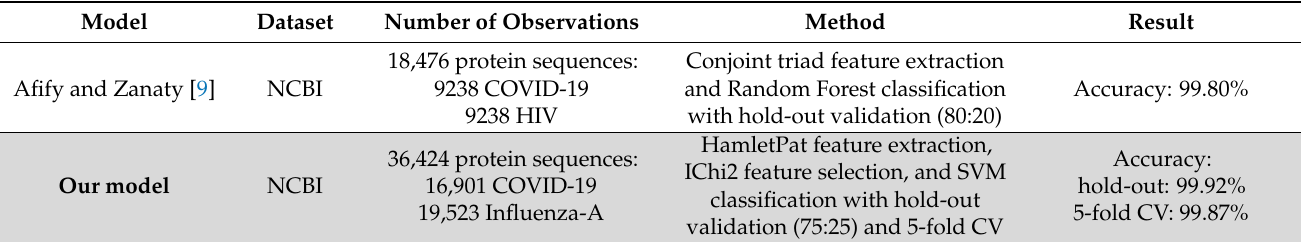
Figure 5. Confusion matrices of the HamletPat-based classification model using hold-out (split ratio 75:25) versus 5-fold cross-validations (CVs). Table 3. Comparative results